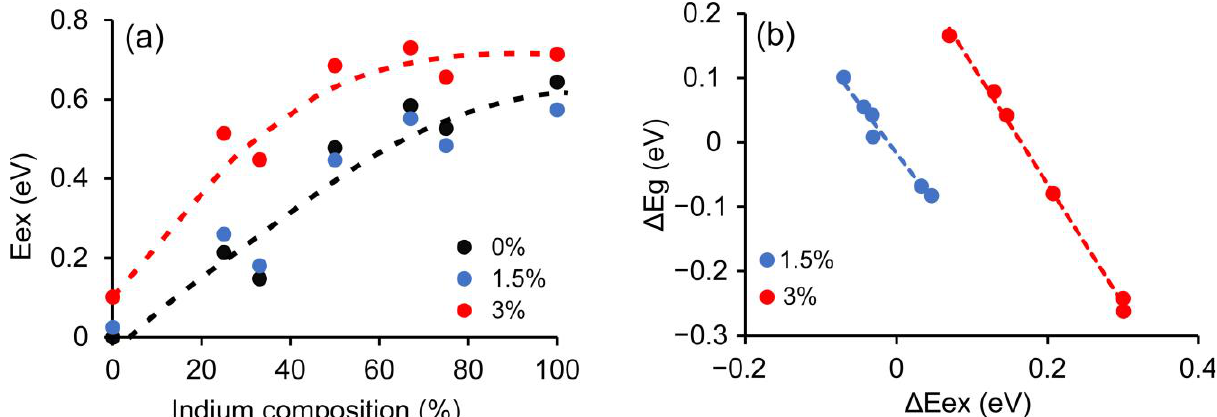
Figure 7. ( a ) Graph of excess energy of studied supercells with respect to quantum well indium content. Trendlines are guides to the eye. ( b ) Graph of band-gap energy change ∆ E g against the change in excess energy ∆ E ex , with reference to the superlattices with relaxed GaN barriers.